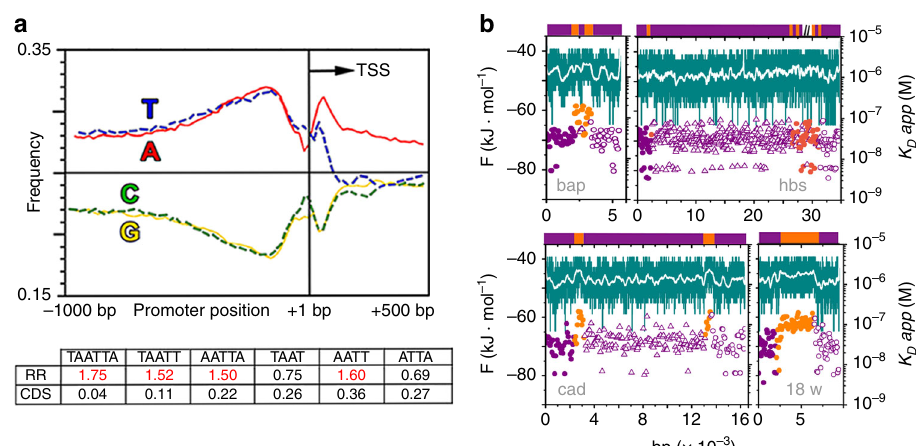
Fig. 7 The genes controlled by Engrailed contain transcription antennas. a Nucleotide composition observed in the promoter regions of Drosophila ( fi gure based on ref. 55 ). TSS indicates the transcription start site observed vs. expected frequency of full, quintet and quartet consensus sites in all of the D. melanogaster genes known to be regulated by Engrailed. RR, regulatory regions; CDS, coding sequence. b Examples of EngHD binding pro fi les for D. melanogaster genes under control by Engrailed ( bap, hbs, cad , and 18w ) predicted by the statistical mechanical model. The colors and symbols are as in Fig. 6b. The results for the 39 genes used in the analysis are summarized in Supplementary Table